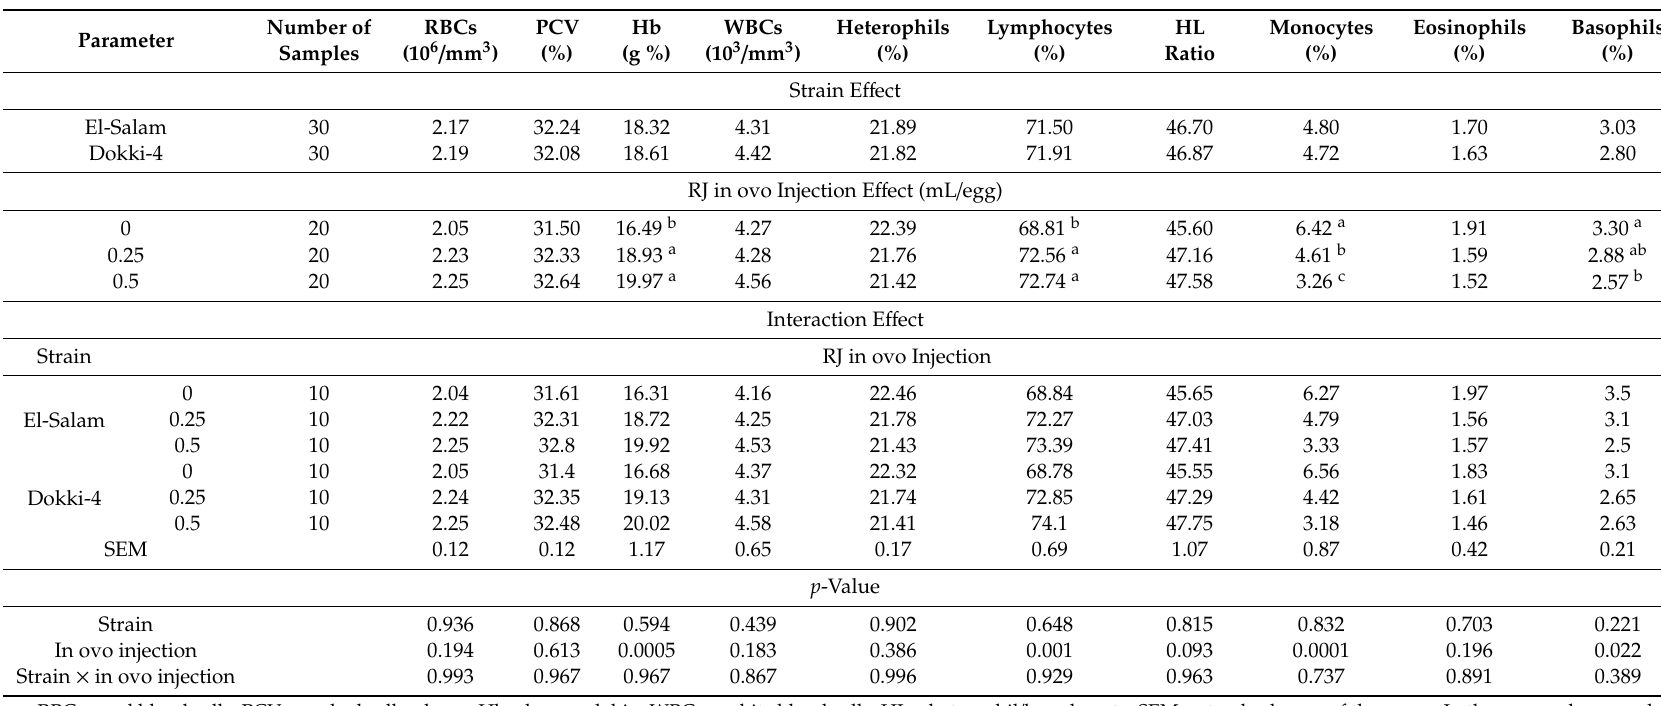
Table 4. E ff ect of in ovo injection of royal jelly (RJ) at two levels (0.25, 0.5 mL / egg) on complete blood count (CBC) of two chicken strains (El-Salam, Dokki-4) as compared to counterpart control chicks (0 mL / egg) and the interaction of strain and treatment